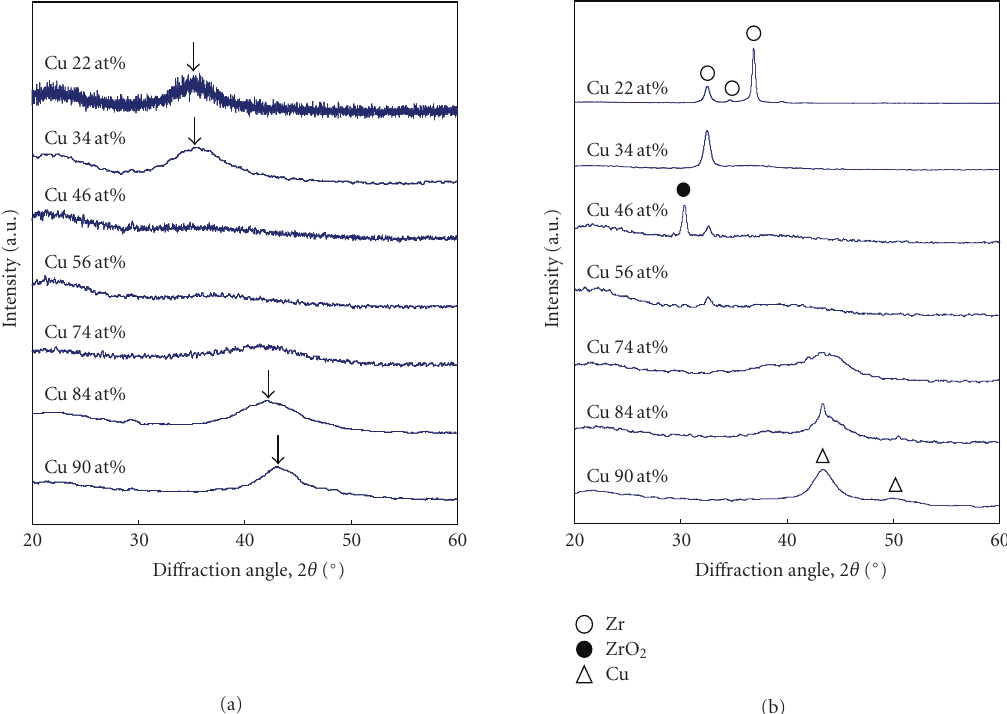
Figure 2: X-ray di ff raction patterns of Zn-Cu binary sputtered films with various Cu contents; (a) as-sputtered films and (b) after annealed at 723 K for 900 seconds in argon gas atmosphere.